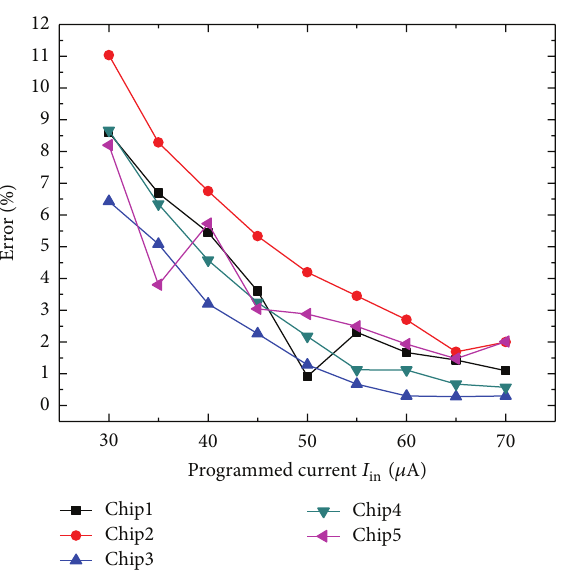
Figure9:Errorpercentagefromoutputcurrent 𝐼 current values 𝐼 in